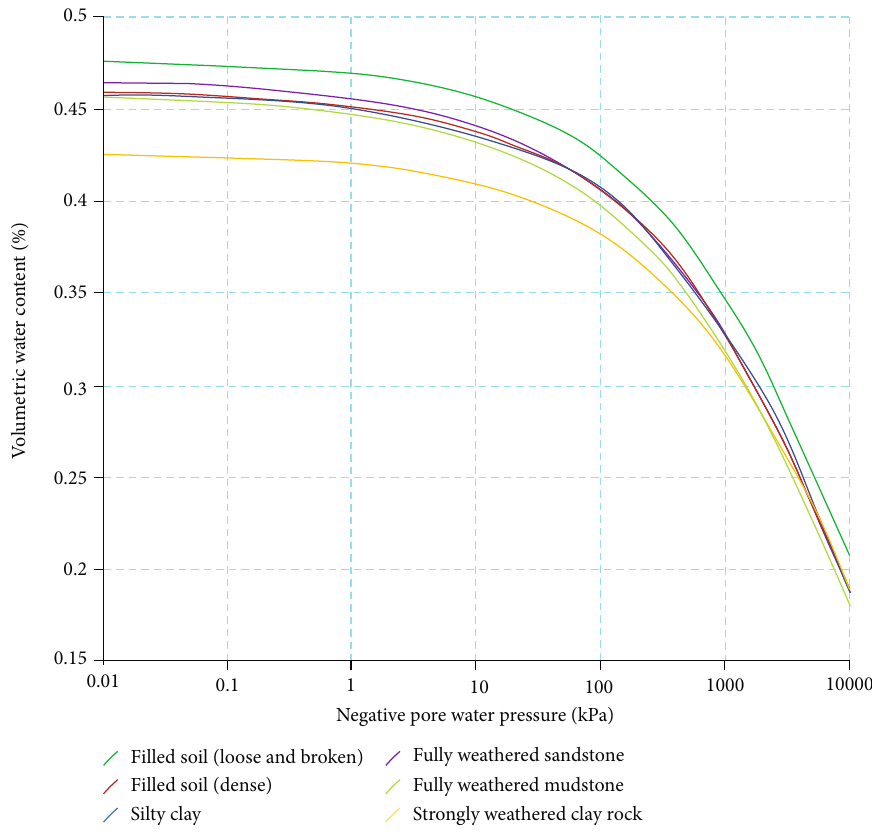
Figure 12: Fredlund-Xing soil-water characteristic curves of each soil mass.